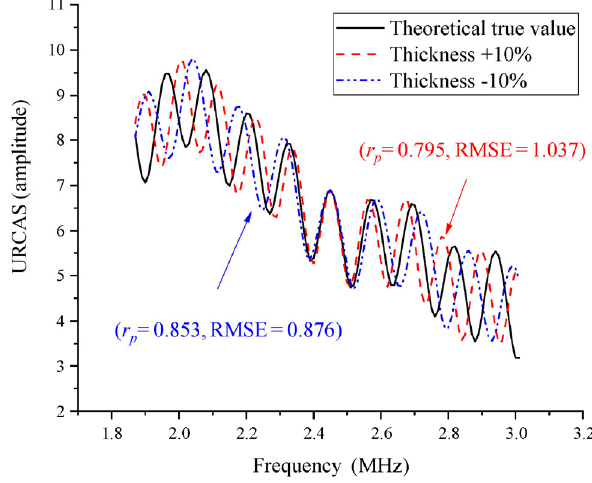
Fig. 4 Effect of acoustic velocity fluctuation ± 10% on URCAS. Fig. 5 Effect of thickness fluctuation ± 10% on